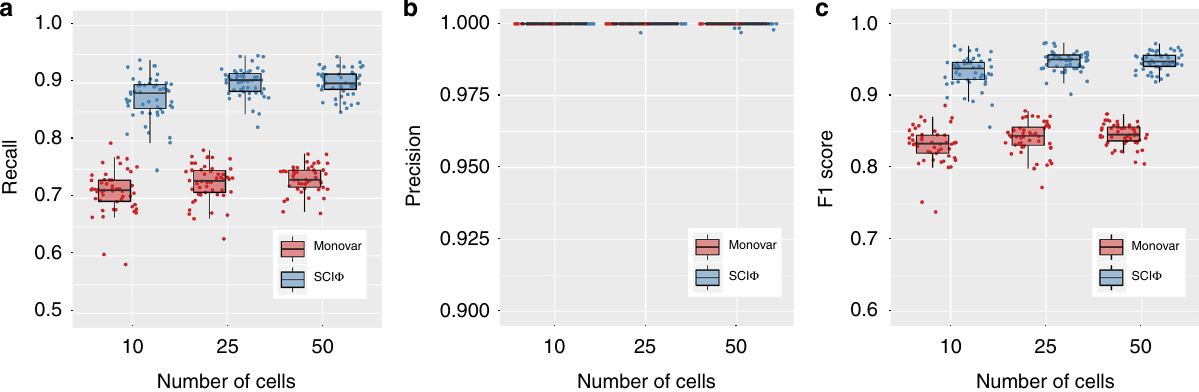
Fig. 2 Performance of SCI Φ and Monovar on simulated data with different number of cells. Performance measured as recall ( a ), precision ( b ), and